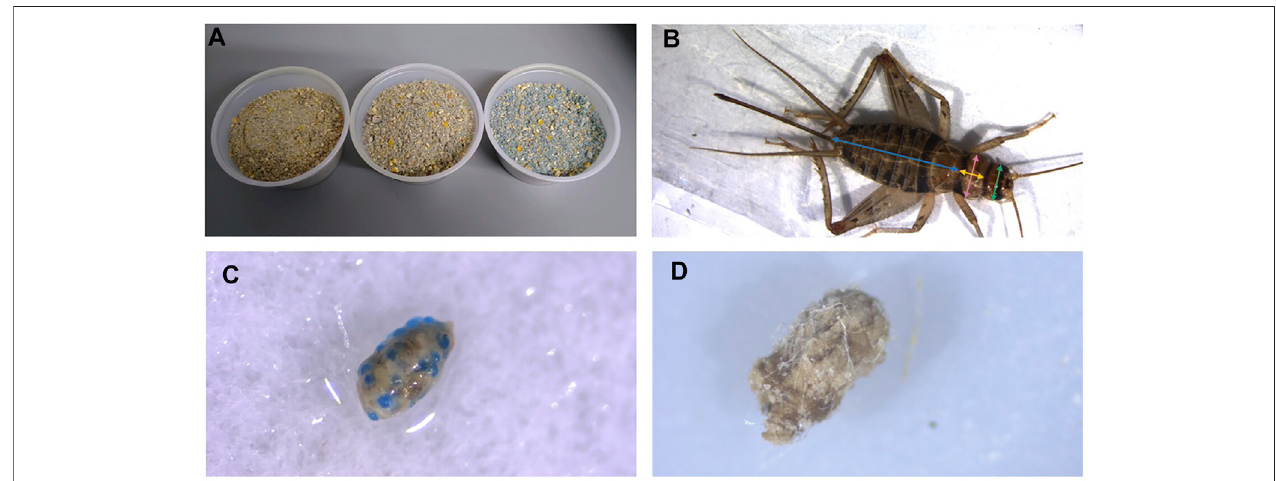
FIGURE 1 | Cricket diet mixed with blue, fl uorescent microplastic beads. Concentrations shown from left to right are 2.5%, 5% and 10% w/w plastic mixed with base diet (A) . Example of measurements taken from crickets. Blue = abdomen length, yellow = thorax width, pink = thorax length, green = head width (B) . Frass embedded with microbeads from crickets feeding on 10% w/w fl uorescent polyethylene microbeads in feed (C) and frass embedded with micro fi bers from crickets feeding on 1% w/w polyethylene terephthalate in feed (D) .